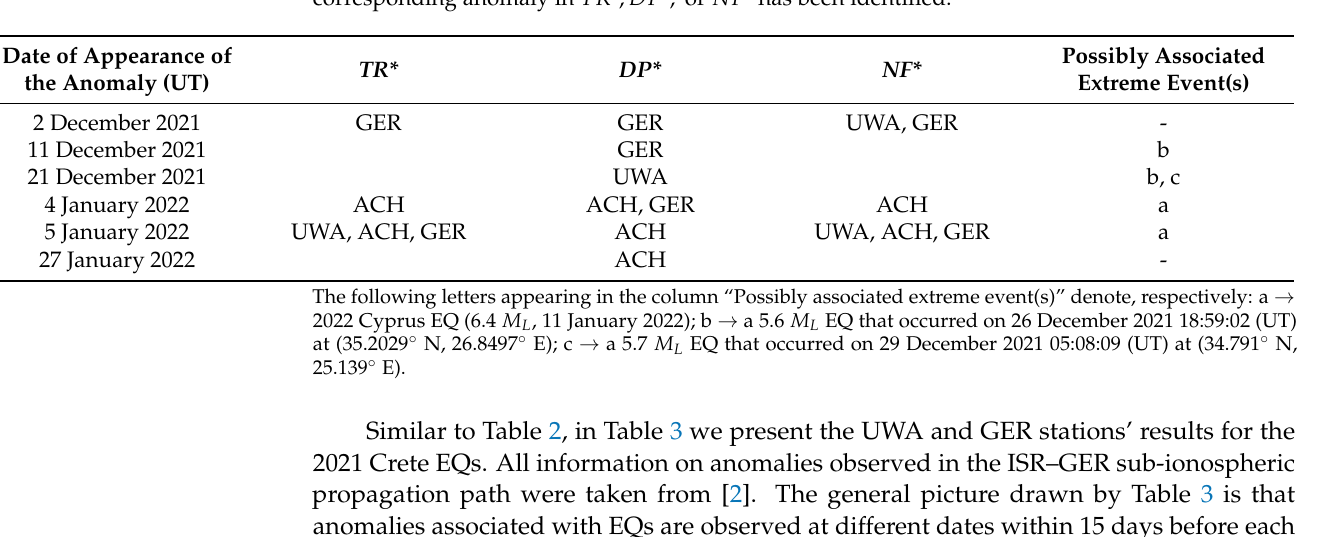
Table 2. Results of NFM for the 2022 Cyprus EQ. UWA, GER, and ACH denote the station where the corresponding anomaly in TR * , DP * , or NF * has been identified.